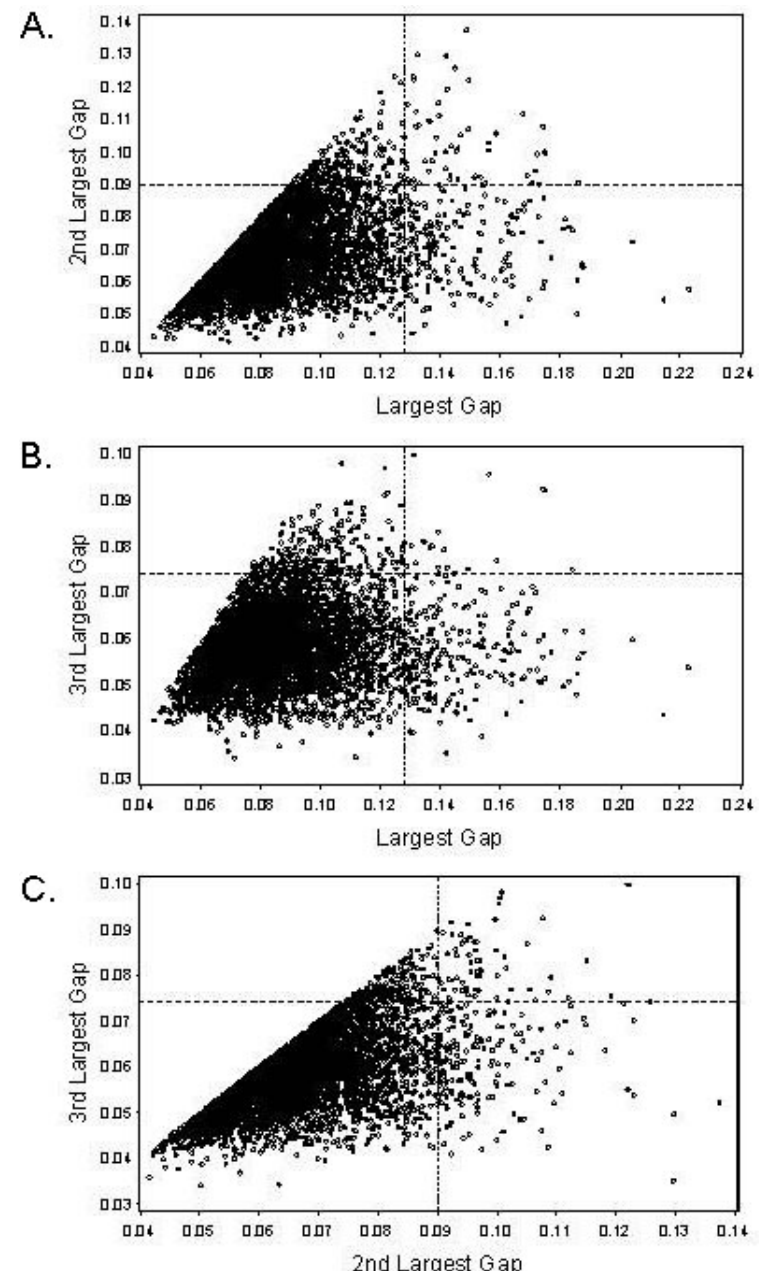
Fig. 2. Comparison of gap sizes generated from 5000 simulations. For each simulation, 50 numbers were randomly selected between 0 and 1, then the largest gap, second largest gap, and third largest gap were determined. 95 th percentiles are depicted by dotted lines—upper right quadrant is the upper 5 th percentile. A) Plot of largest gap vs. second largest gap, B) largest gap vs. third largest gap, C) second largest gap vs. third largest